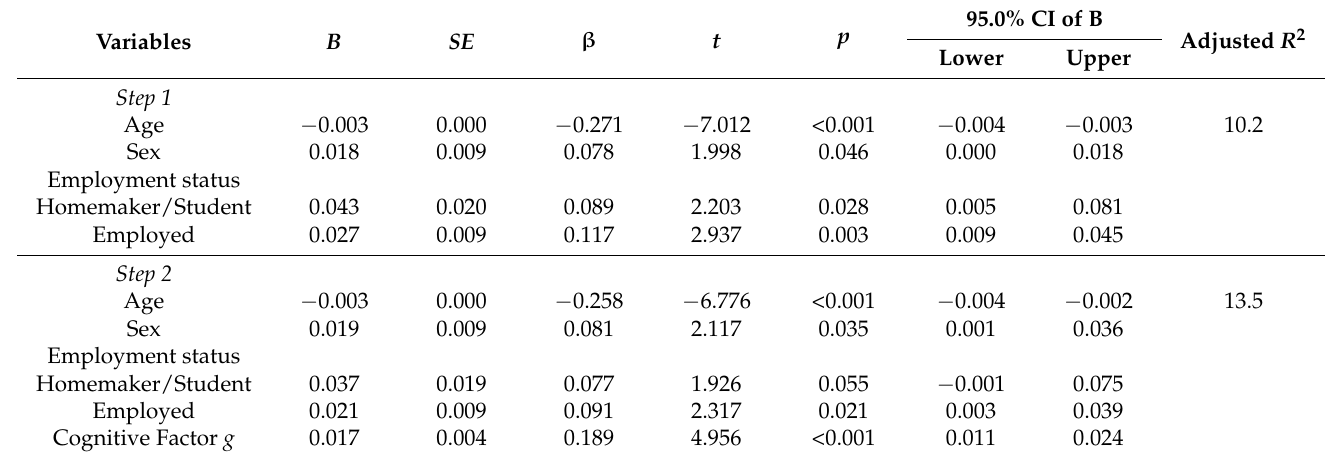
Table 3. Summary of hierarchical multiple regression